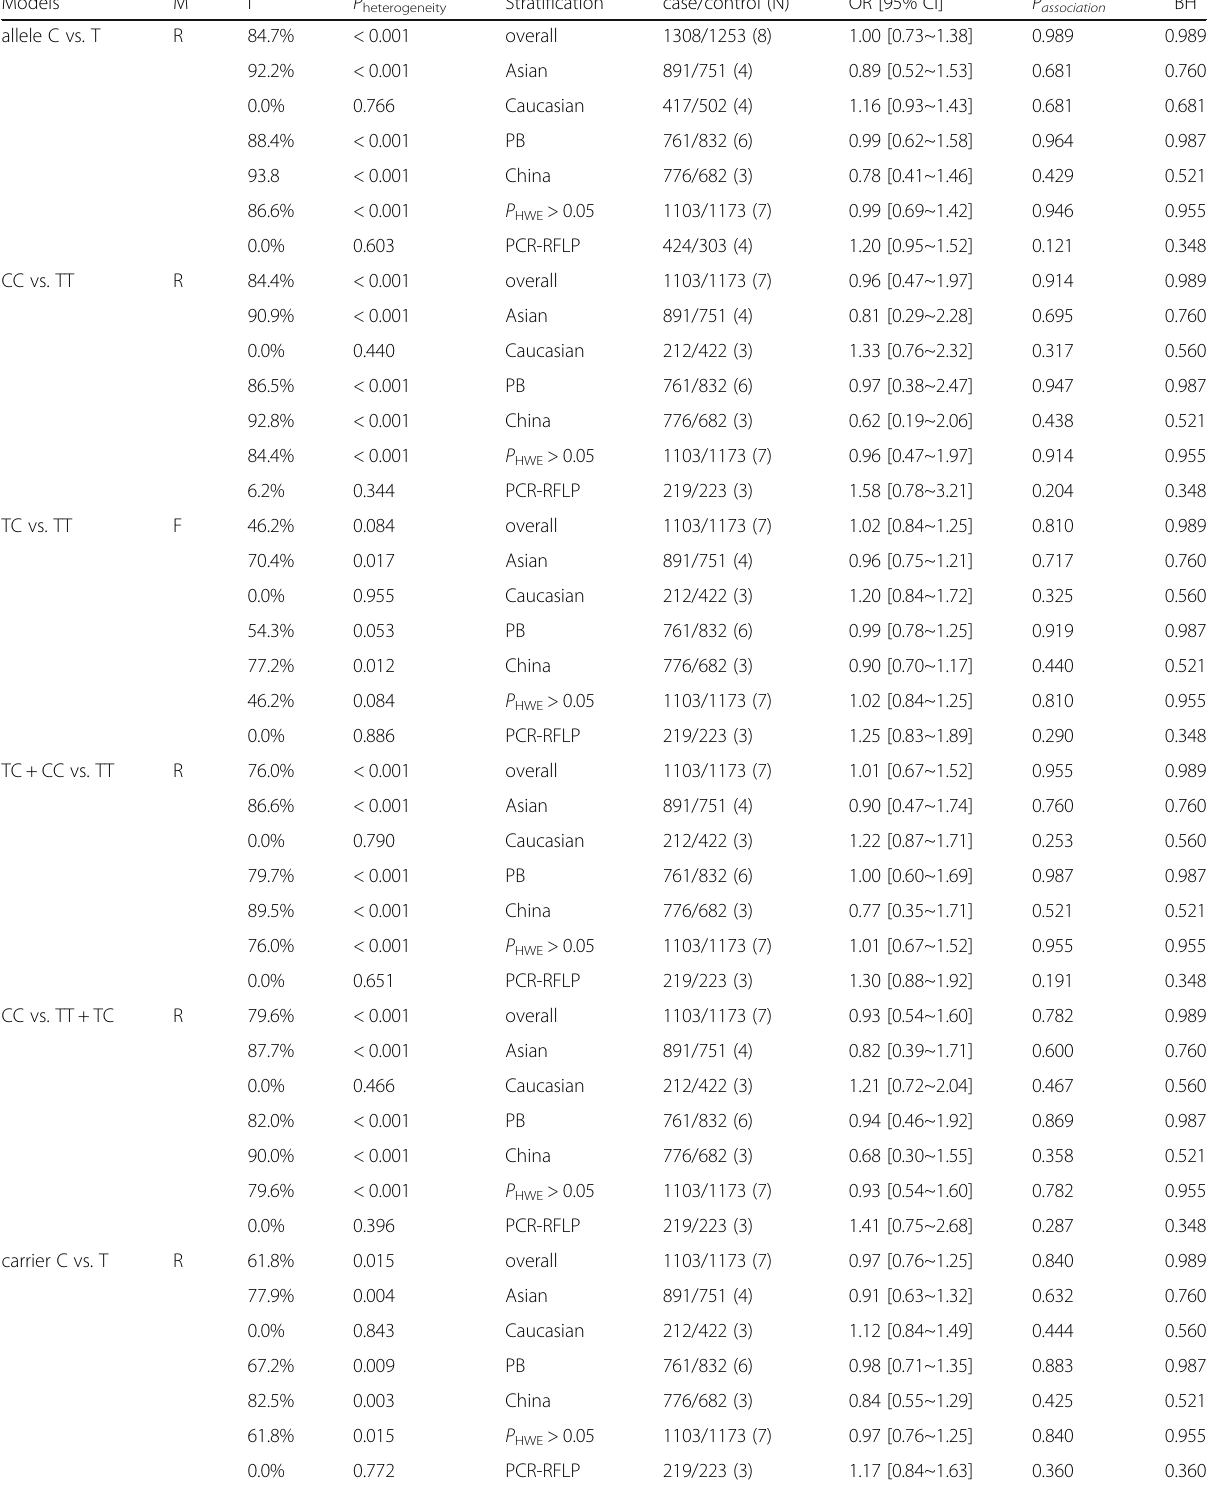
Table 4 Pooled analyses of the association between VDR rs2228570 polymorphism and susceptibility to psoriasis